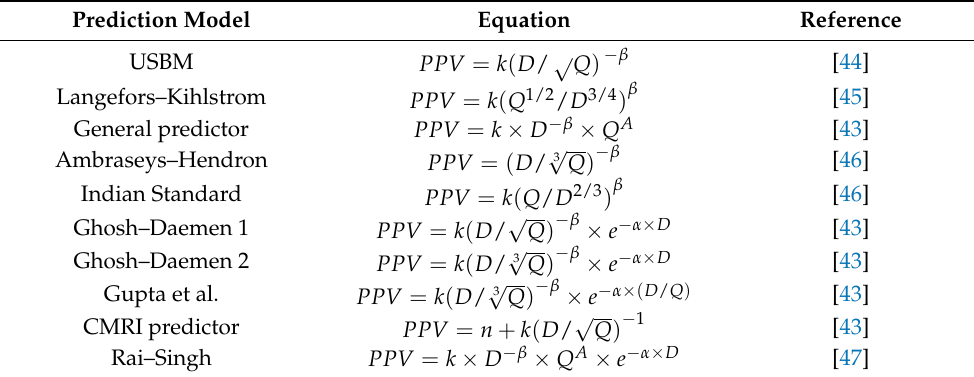
Table 3. Empirical models for predicting blast-induced ground vibrations.